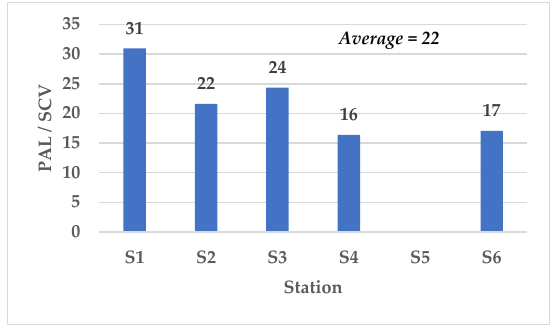
Figure 9. Ratio of PAL (m) to SCV) (m 3 ) per station.